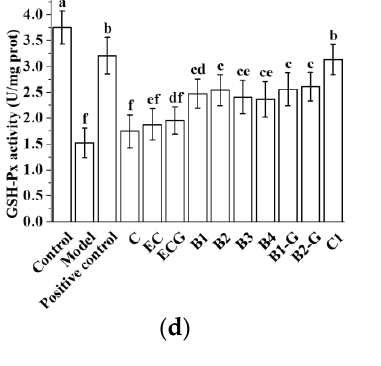
Figure 4. Effects of different structural procyanidins on oxidative stress in the PC12 cell PD model. ( a ) Representative fluorescence photomicrographs of PC12 cells. ( b ) ROS level. ( c ) MDA level. ( d ) GSH-Px activity. ( e ) CAT activity. ( f ) SOD activity. Control, Blank control group; Model, MPP + (1.5